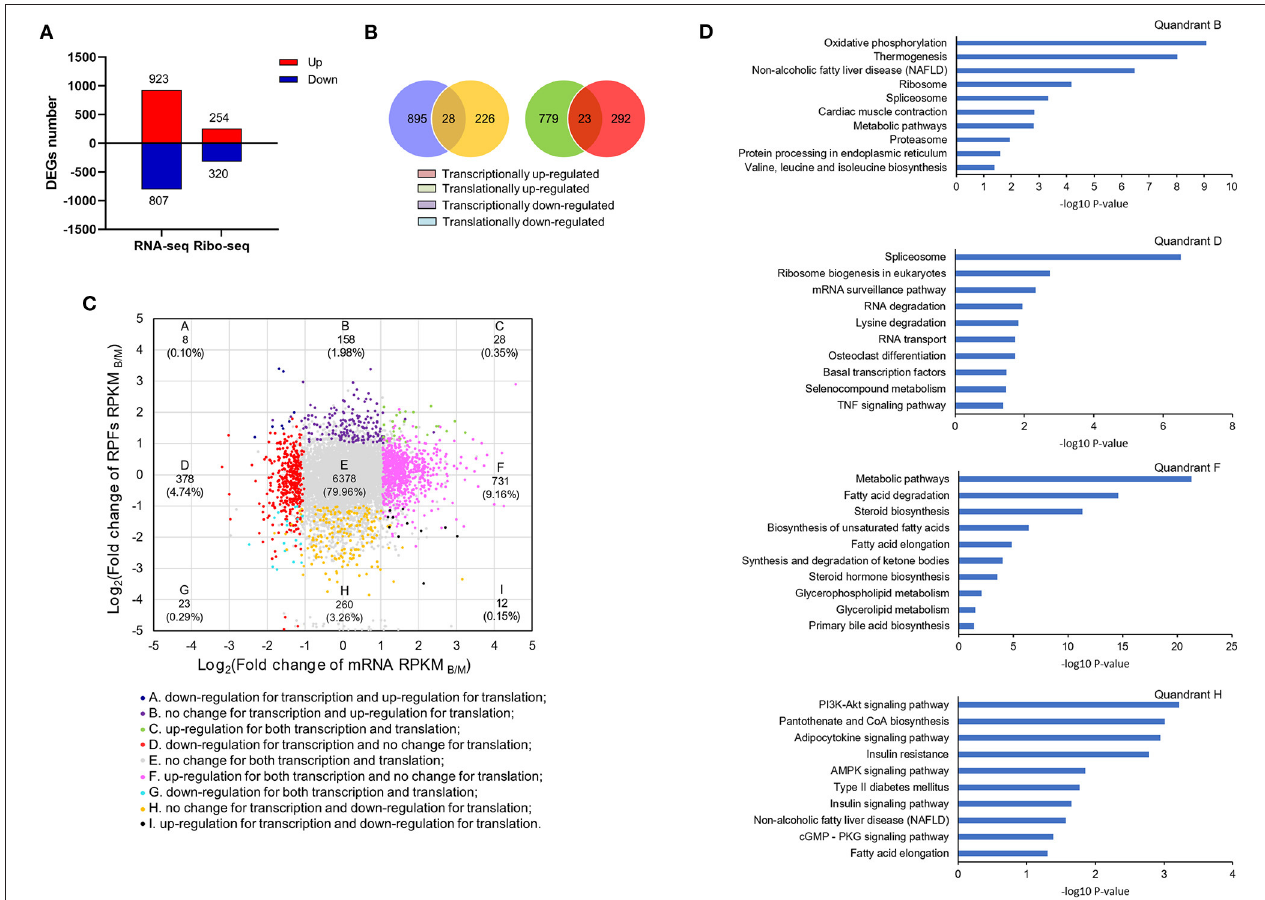
FIGURE 5 | Joint analysis of transcriptome and translatome. (A) The number of DEGs at transcriptional and translational levels. (B) The relationships of DEGs at transcriptional and translational levels. (C) Quadrant diagram of the fold change of the B/M group at transcriptional and translational levels. (D) KEGG analysis of genes in classes B, F, D and